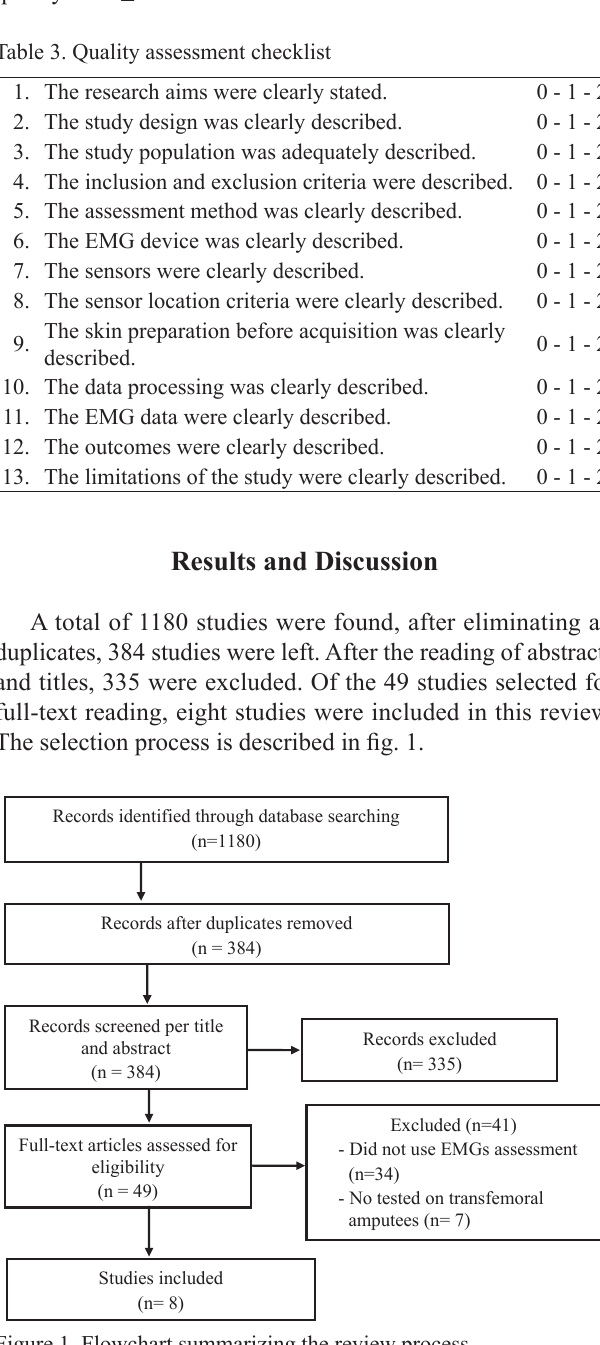
Figure 1. Flowchart summarizing the review